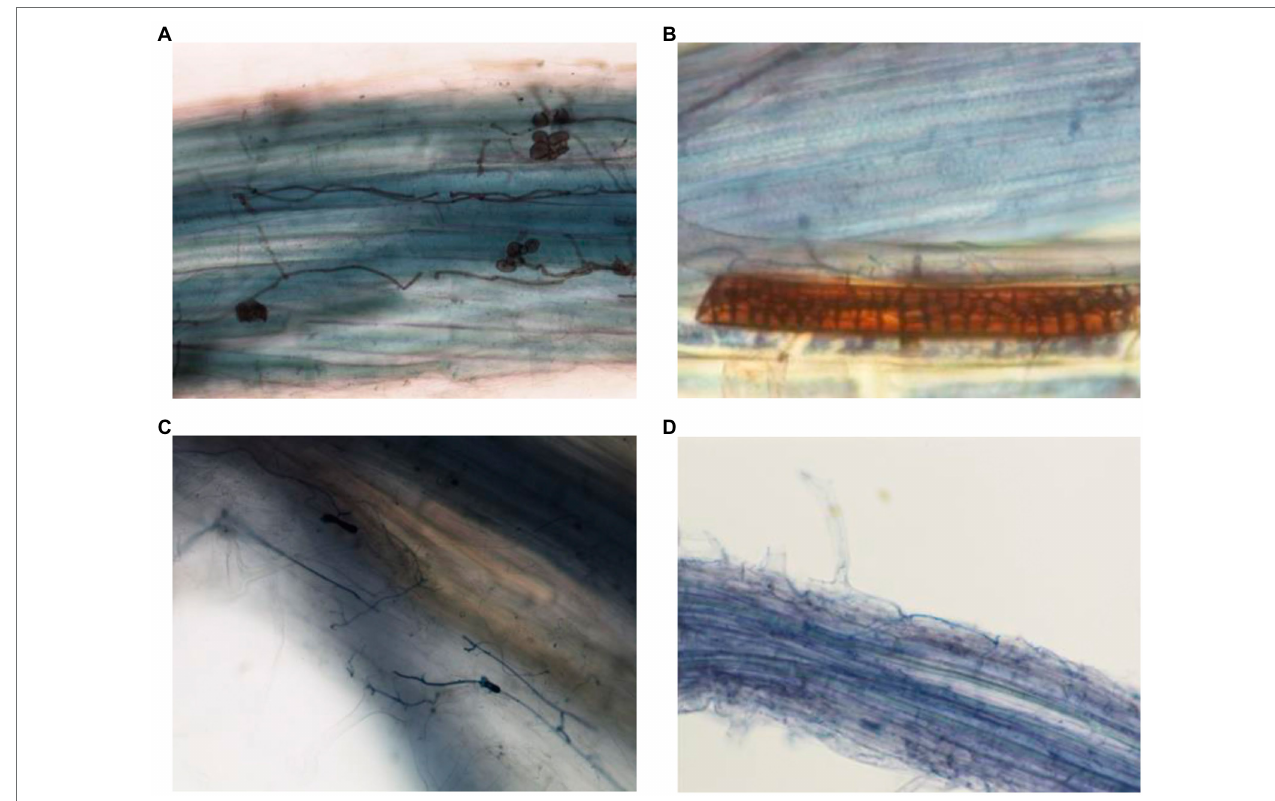
FIGURE 7 | Fungal structures observed by light microscopy in roots of plants inoculated with P. macrospinosa (A,B) and F. oxysporum (C,D) . In roots inoculated with Periconia , melanized septate hyphae and spores (A) and microsclerotia (B) are visible. In Fusarium -inoculated plants, hyphae are visible in the root